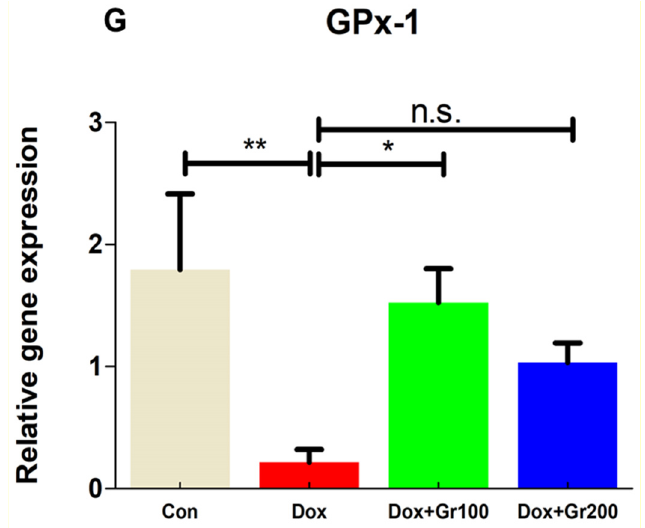
Figure 3. ( A – G ) Effects of geraniol (Gr), doxorubicin (Dox), or their combination (Dox + Gr100 and Dox + Gr200) on protein and gene expression of antioxidant stress markers. Data are presented as mean + SD (n = 6). *, p < 0.05; **, p < 0.01; ***, p < 0.001; n.s., p > 0.05 or non-significant. Gr100 and Gr200 indicate 100 and 200 mg of geraniol per kilogram of body weight, respectively.